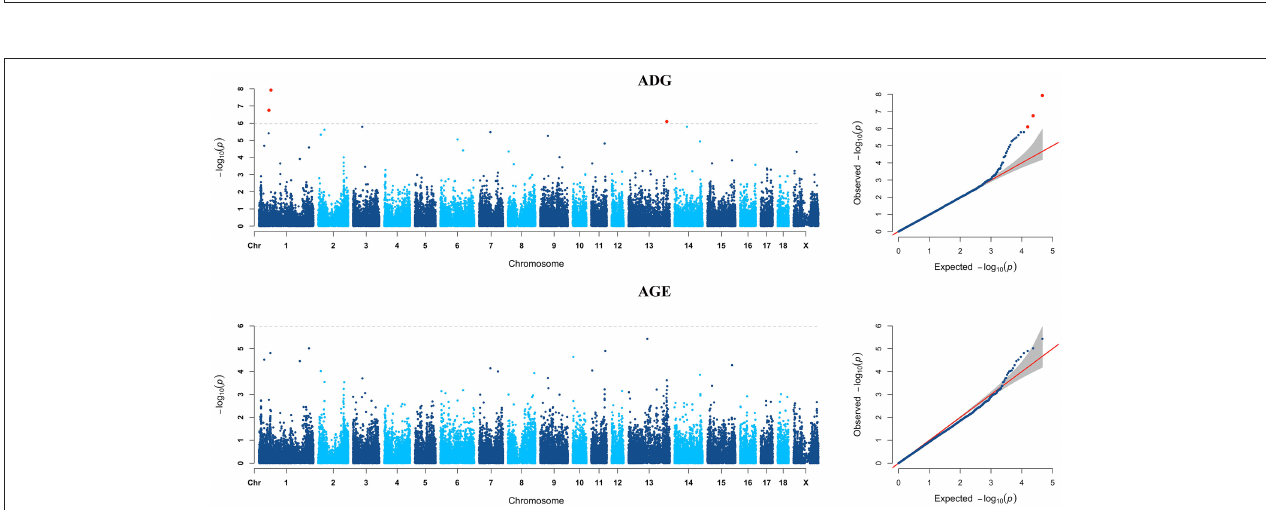
FIGURE 3 | Manhattan plots and Quantile-Quantile (QQ) plots for both ADG and AGE traits of Landrace breed. The signals of genome-wide significant SNPs are colored in red.